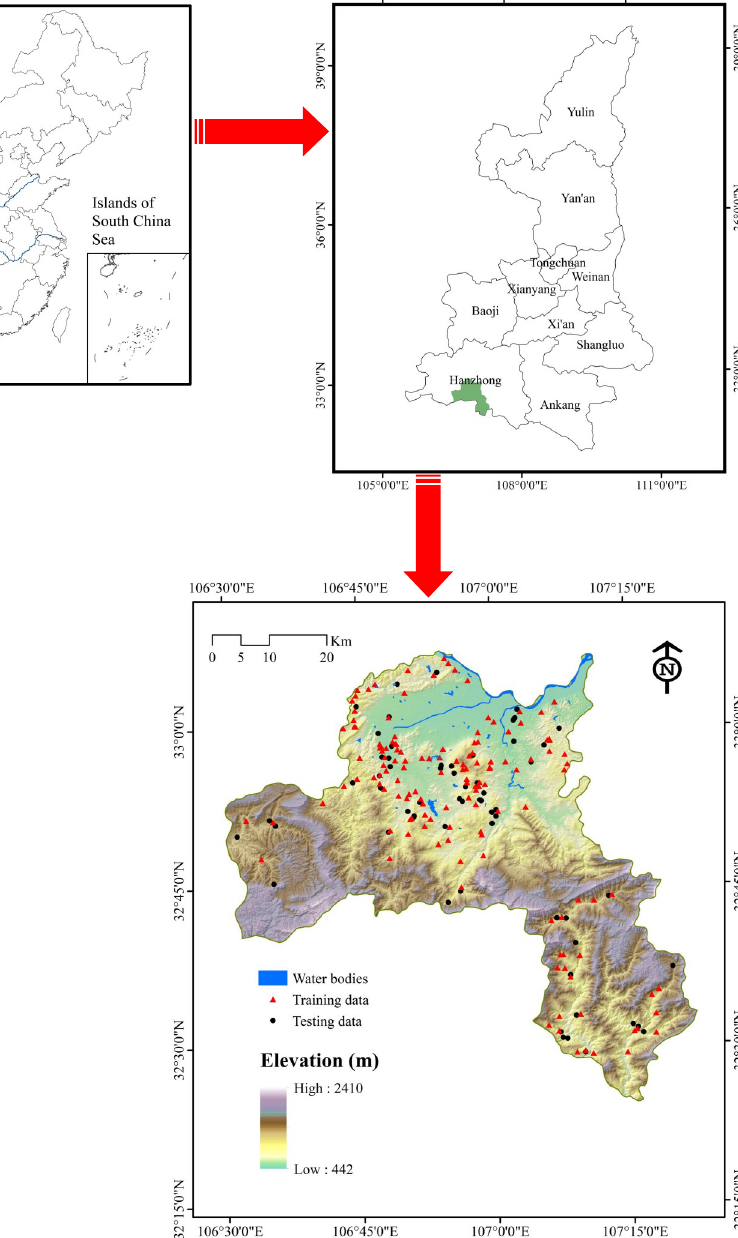
Figure 1. Location of the study area.